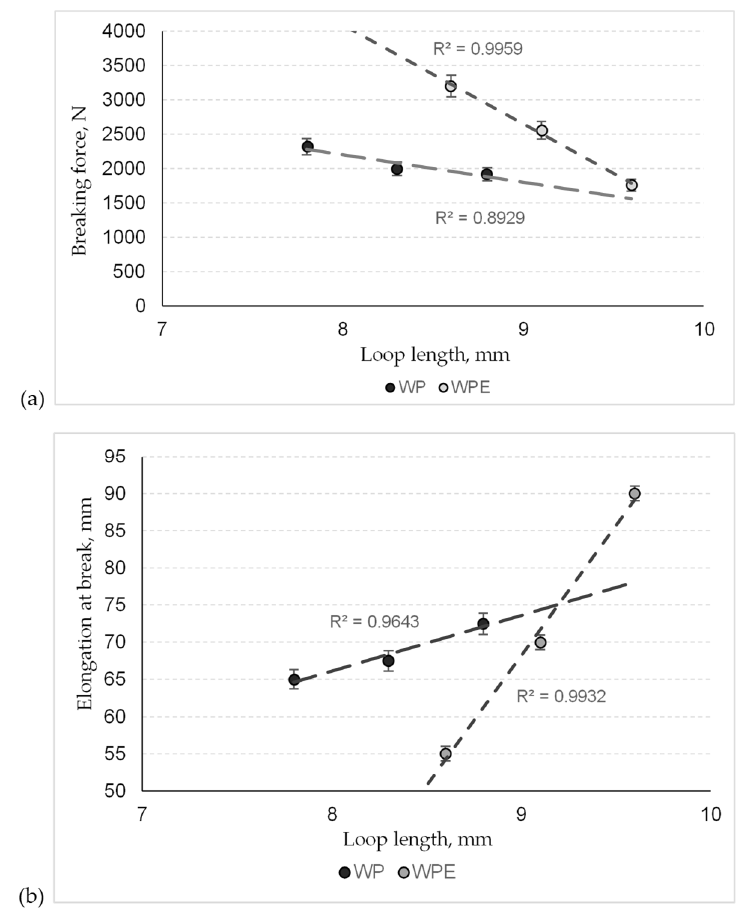
Figure 2. Tensile characteristics: ( a ) breaking force and ( b ) elongation at break.